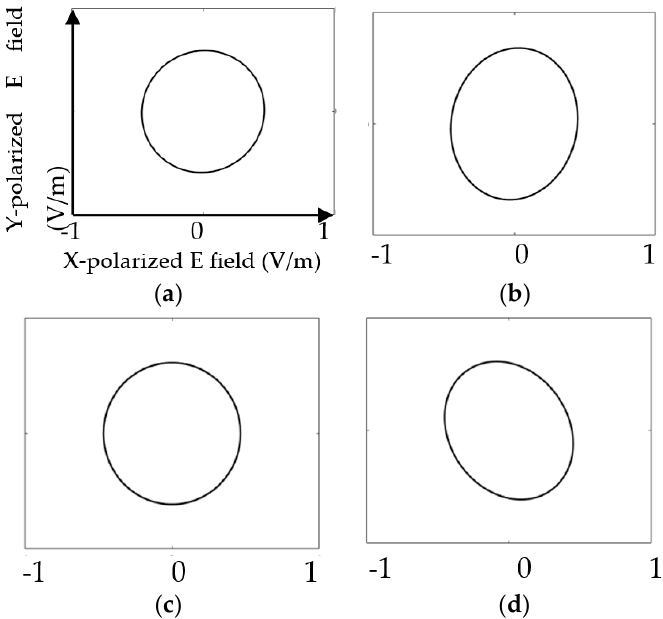
Figure 9. Polarized wave trajectory at frequencies of ( a ) 1.085THz, ( b ) 1.387 THz, ( c ) 1.175 THz, and ( d ) 0.995 THz.